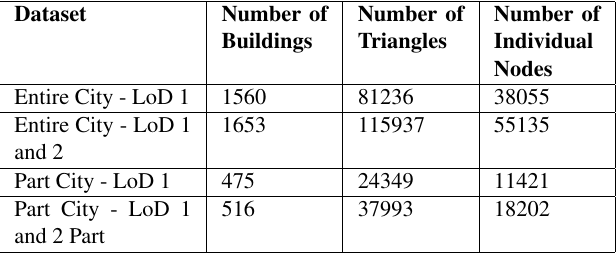
Table 3: Index Table Structure